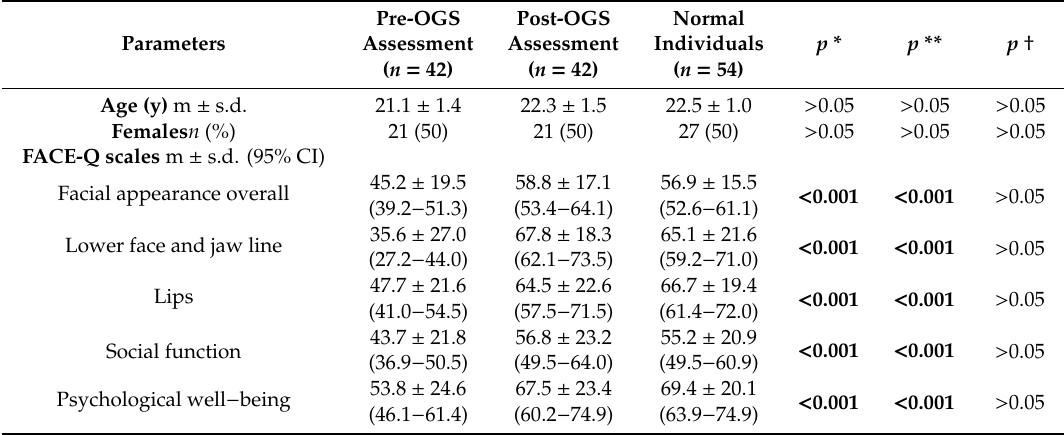
Table 1. Characteristics and FACE-Q reports of patients and normal individuals.